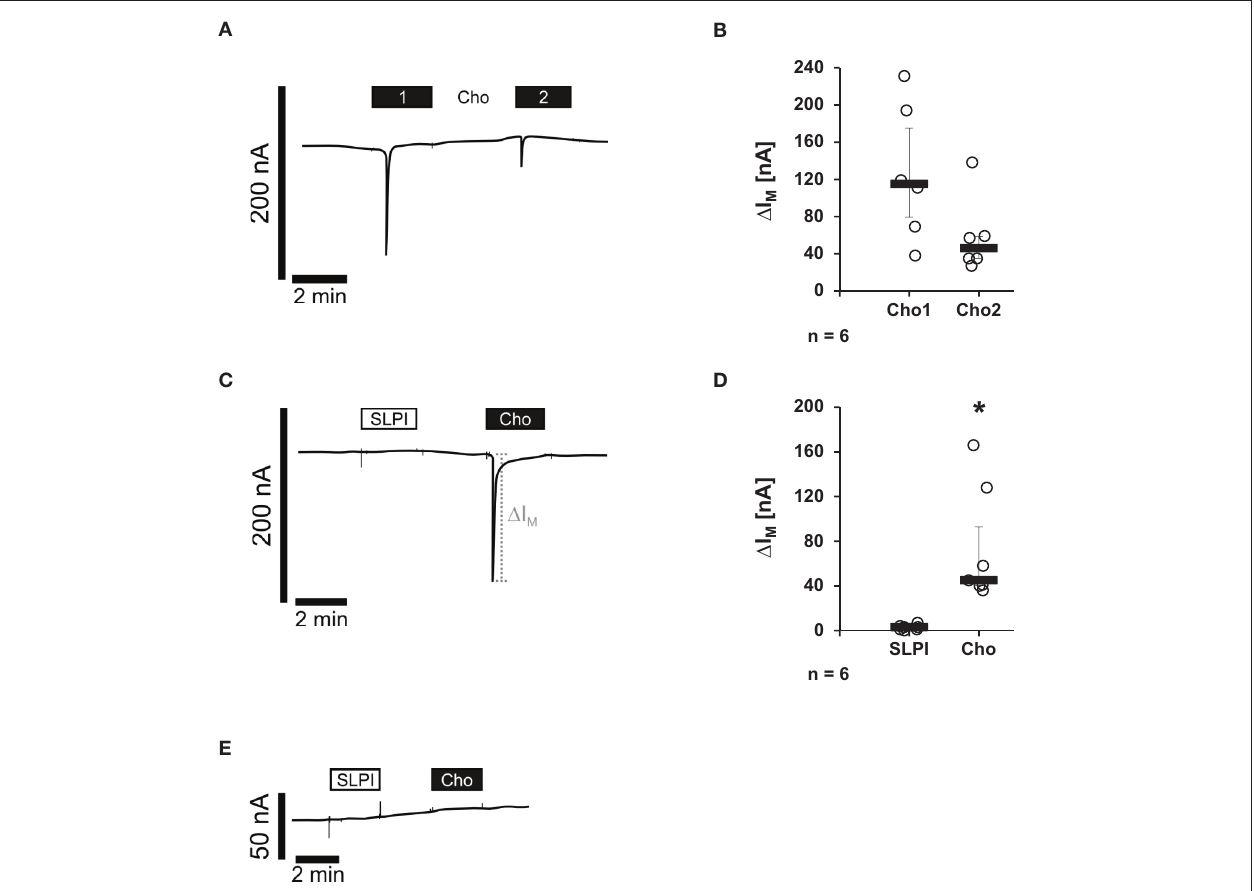
FIGURE 7 | SLPI does not induce ion channel functions at oocytes co-expressing nicotinic acetylcholine receptor (nAChR) subunits α 7, α 9, and α 10. Two-electrode voltage-clamp measurements (TEVC) were performed on Xenopus laevis oocytes that heterologously co-expressed human nAChR subunits α 7, α 9, and α 10. (A–D) Choline (Cho) induced repeatable current responses, whereas initial SLPI application had no impact on ion currents. (A,C) Representative current curves are shown. (C,D) Graphical representation of the results of experiments shown in (B,D) . (E) In water-injected control oocytes, neither SLPI nor Cho application induced any current response. * p ≤ 0.05 significantly different compared to cells stimulated with SLPI. Experimental groups were compared by Wilcoxon signed-rank test.